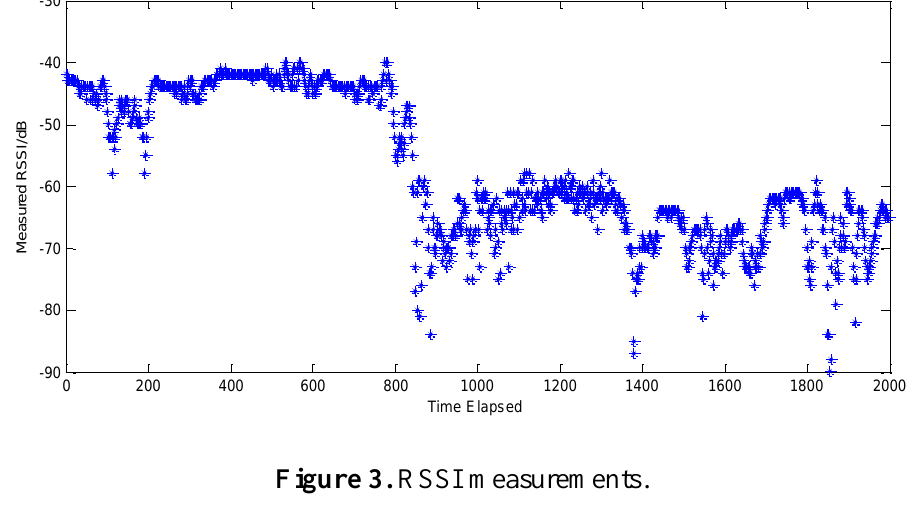
Figure 3. RSSI measurements.